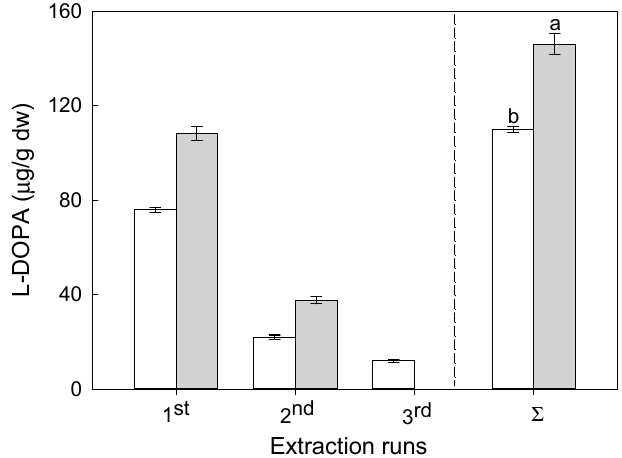
Figure 4. L -DOPA concentration as a function of the extraction runs for 1:10 (white bars) and 1:25 (grey bars) solid mass/solvent volume ratio. The total L -DOPA amounts obtained after three extraction runs for both systems is given for comparison purposes. Different letters next to L -DOPA content indicates statistically significants differences according to the Tukey’s test ( p > 0.05).